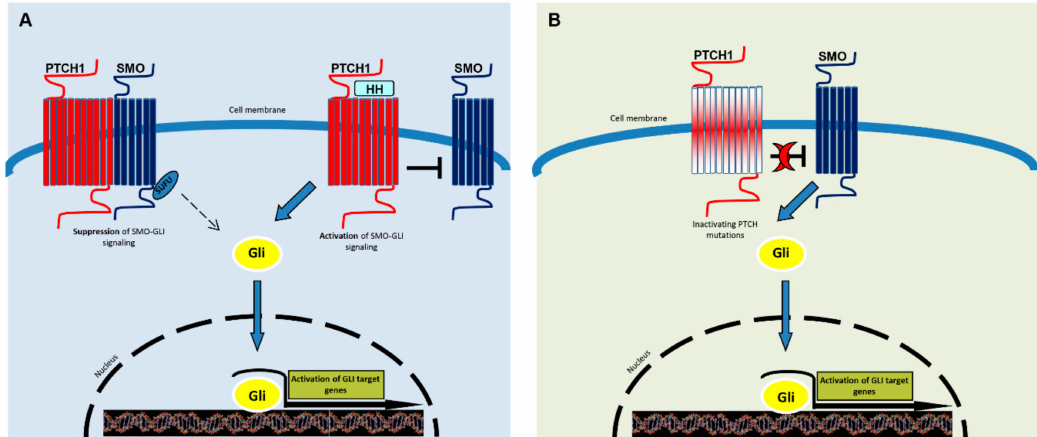
Figure 1. A simplified representation of the Hedgehog signaling pathway. SMO is the key signal transducer of the Hh pathway. ( A ) In the absence of Hedgehog (Shh, Dhh, Ihh) ligands, PTCH1 inhibits SMO signaling. Gli molecules are processed with the help of SuFu molecules into repressor forms, which disable the Hh signaling pathway. The binding of Hh promotes SMO conformational change, leading to activation of the GLI transcription factors (the activators Gli1 and -2 and the repressor Gli3). Activated GLI accumulates in the nucleus and controls the transcription of hedgehog target genes. ( B ) Mutated PTCH1 does not inhibit SMO and the pathway results activated, as in the presence of